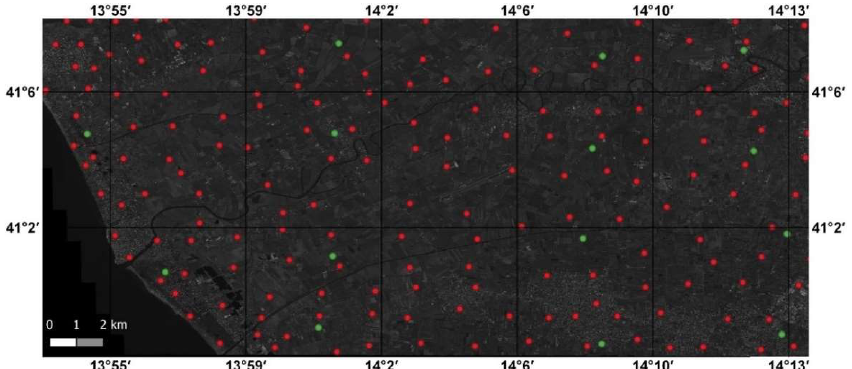
Figure 12. The GCPs (red dots) and CPs (green dots) chosen for the orthorectification of the GeoEye-1 image. Table 3. Statistical values of the CP residuals for GeoEye-1 orthorectification.